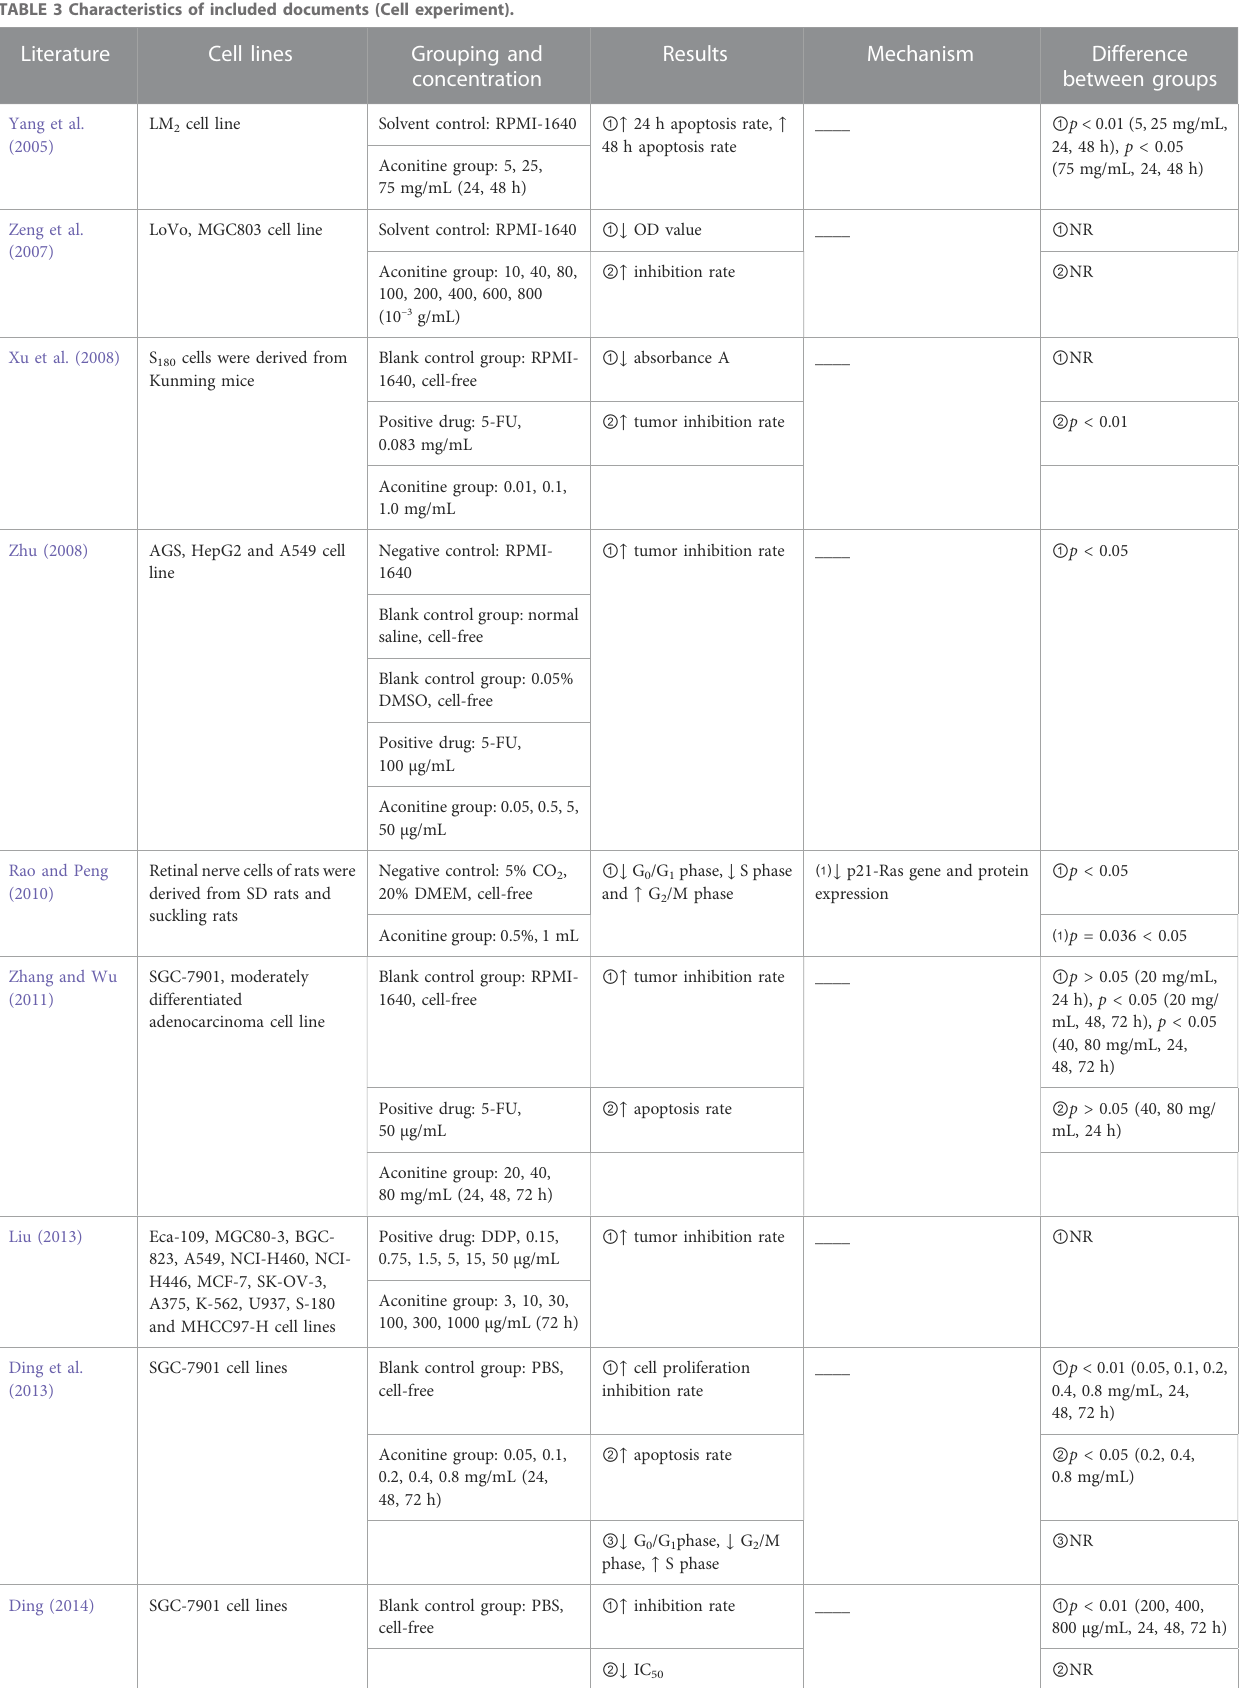
TABLE 3 Characteristics of included documents (Cell experiment).